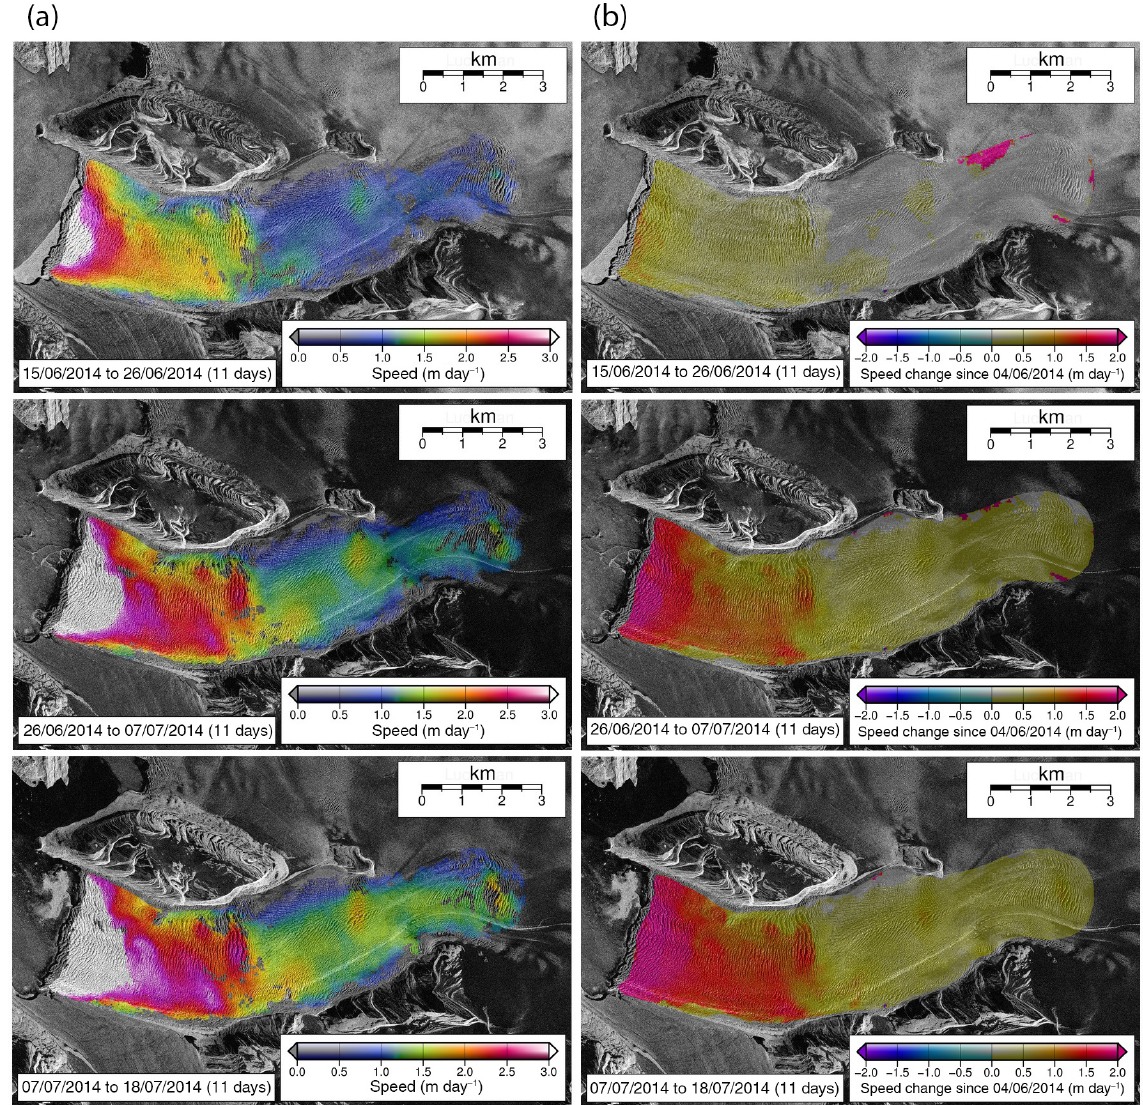
Figure 5. Sequential velocity maps from Kronebreen showing velocity from image-to-image (a) and absolute velocity difference since 4 June 2014 (b) . These velocities are calculated from feature tracking through TerraSAR-X imagery, spanning 15 June to 18 July 2014. Maps show velocity differences between the northern and southern regions of the glacier tongue, with the highest velocities associated with the southern region. There is also a distinct boundary in the velocity field approx. 3km up the glacier tongue. This boundary is due to a high in the bed topography. The seasonal speed-up is generally consistent across the entire front, as shown in the maps depicting absolute velocity